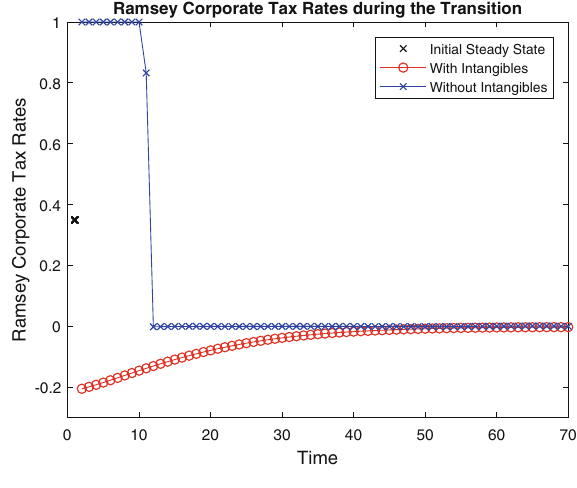
Fig. 1 Ramsey corporate tax rates during the transition